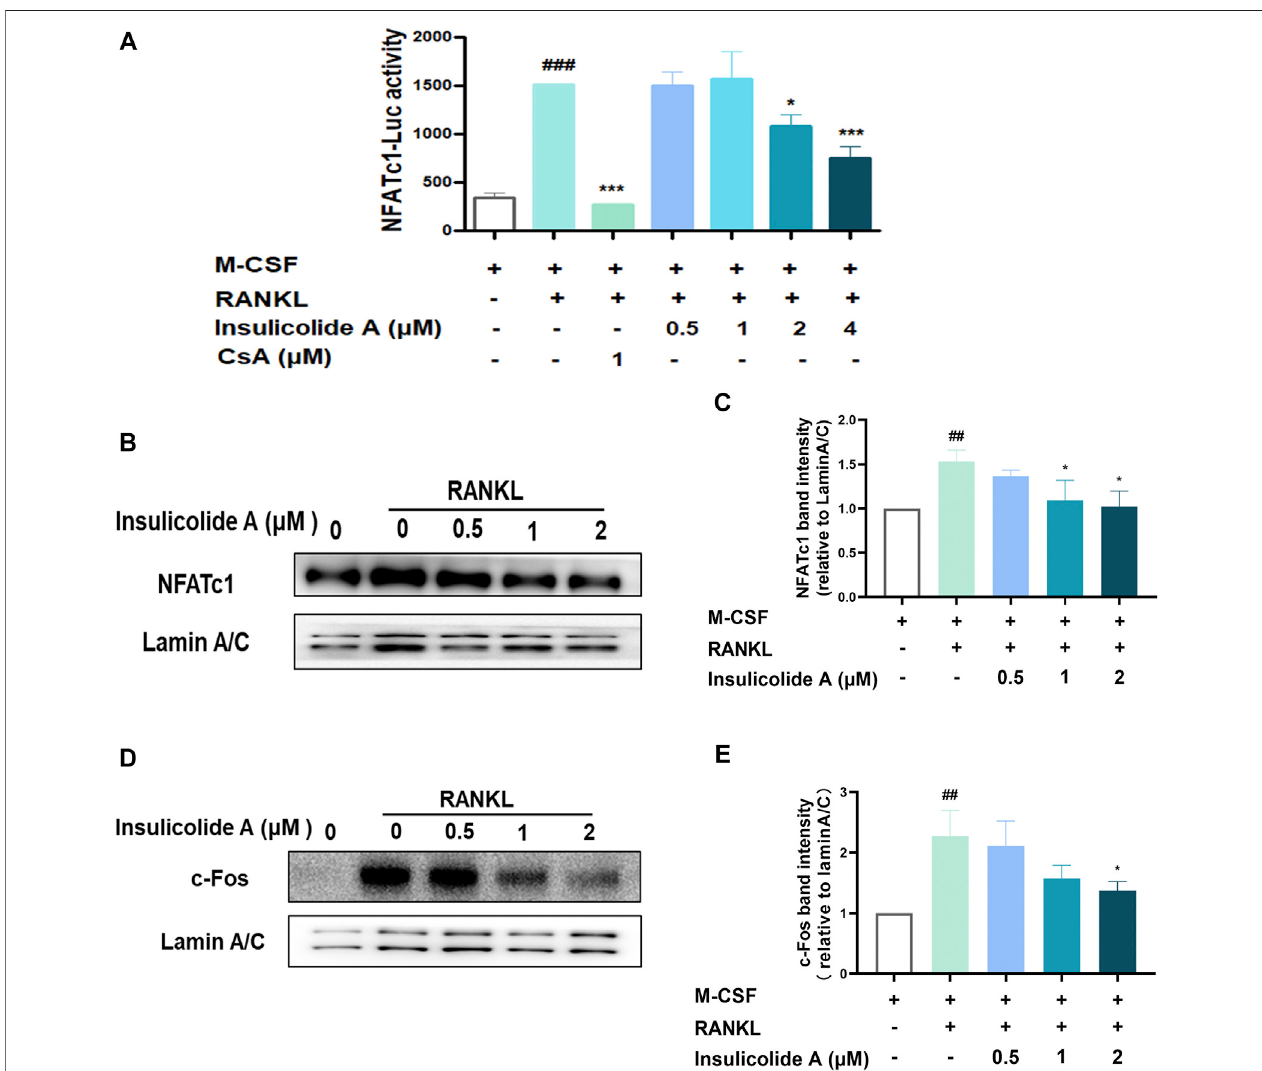
FIGURE 3 | Insulicolide A inhibited RANKL-induced c-Fos/nuclear factor of activated T-cells cytoplasmic 1 (NFATc1) signaling pathway. RAW264.7 cells, stably transfectedbyNFATc1luciferase reportervector, were fi rstpretreated byinsulicolideA(0.5 – 4 μ M) for4 h,thenfollowedby100 ng/mlofRANKL stimulation for6 h,and the luciferase activity (A) was assayed later. Insulicolide A (0.5 – 2 μ M) in BMMs were fi rst cultured for 4 h, then followed by 100 ng/ml of RANKL stimulation for 30 min. Afterthat,nuclearproteinswereharvestedanddetectedbyNFATc1,c-Fos,andLaminA/Cantibodies.Therelativeexpressionof (B,C) NFATc1toLaminA/Cor (D, E) c-Fos to LaminA/C were analyzed. The data are shown as means ± SD of three independent experiments. ## p < 0.01, ### p < 0.001 vs. nontreatment groups, * p < 0.05, *** p < 0.001 vs. RANKL-induced groups.